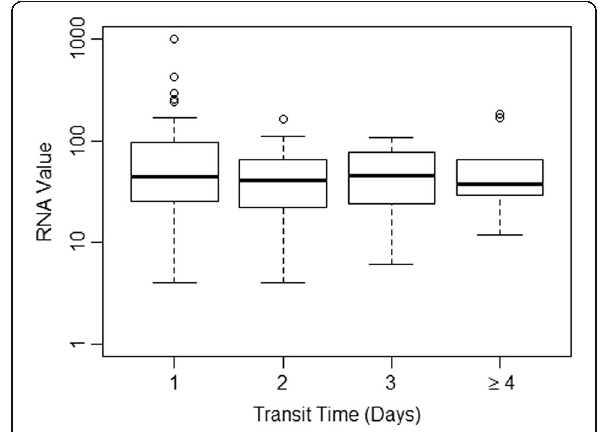
Fig. 6 Boxplot summarizing the influence of time on RNA value using samples collected in stabilization buffer. The box represents the inter-quartile range and the line in the box represents the median. The whiskers represent the minimum and maximum values